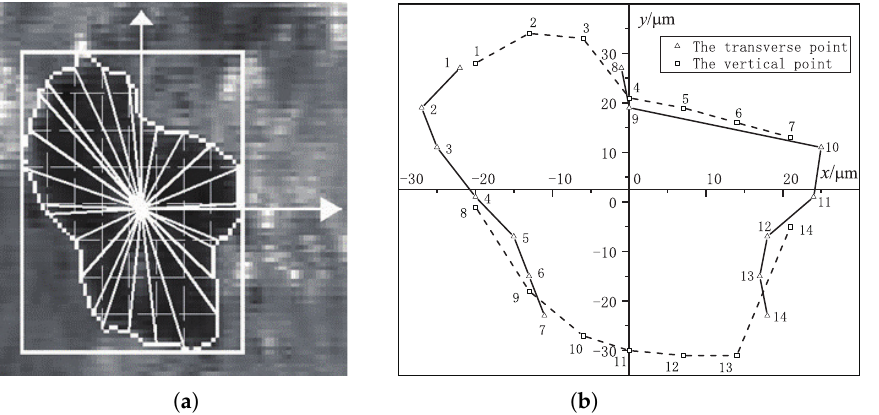
Figure 6. ( a ) The grain 1 (G1) in the rectangular coordinate system; ( b ) the transverse and vertical